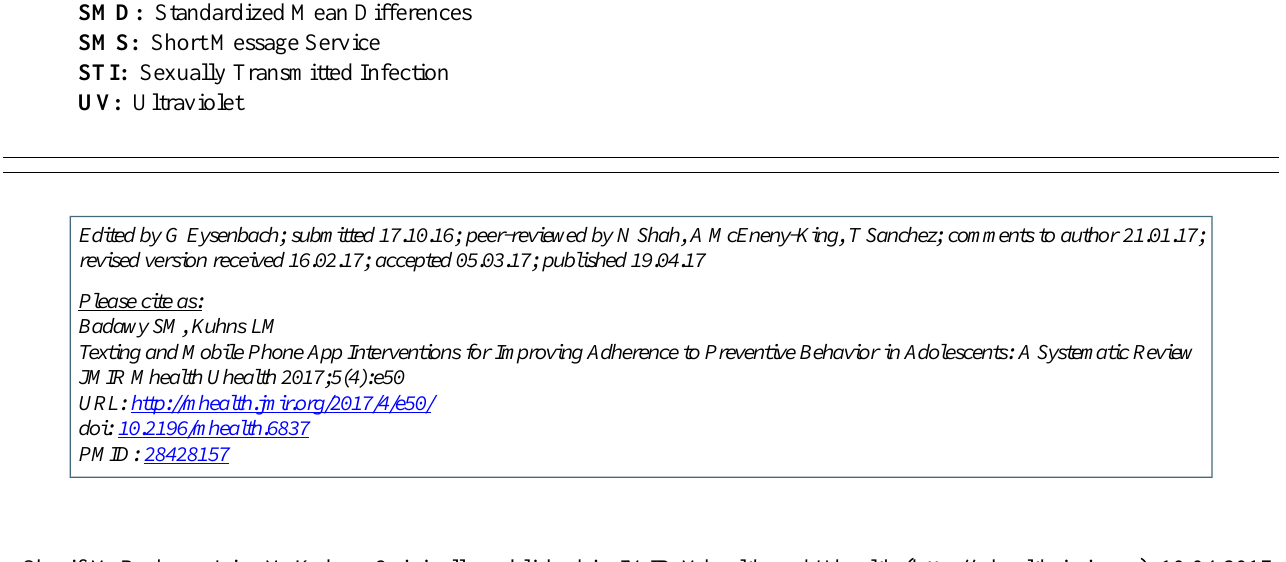
SMD: Standardized Mean Differences SMS: Short Message Service STI: Sexually Transmitted